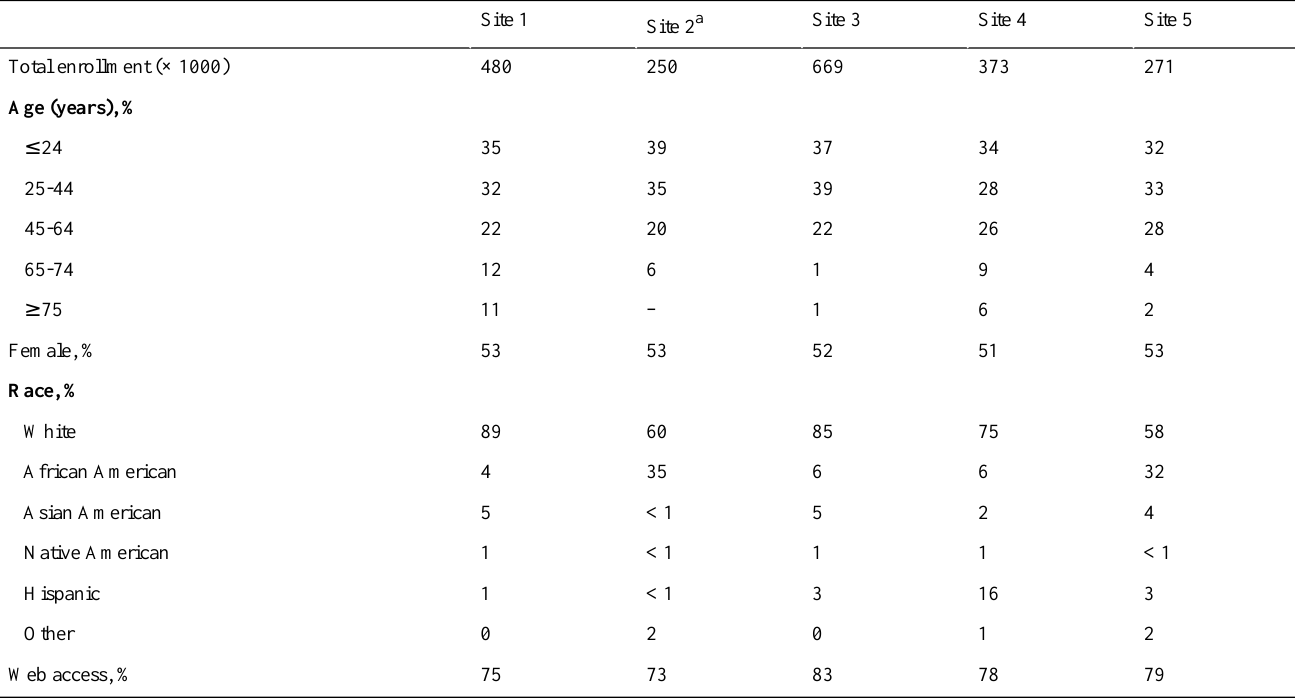
Table 1. Characteristics of the entire membership of participating MENU health